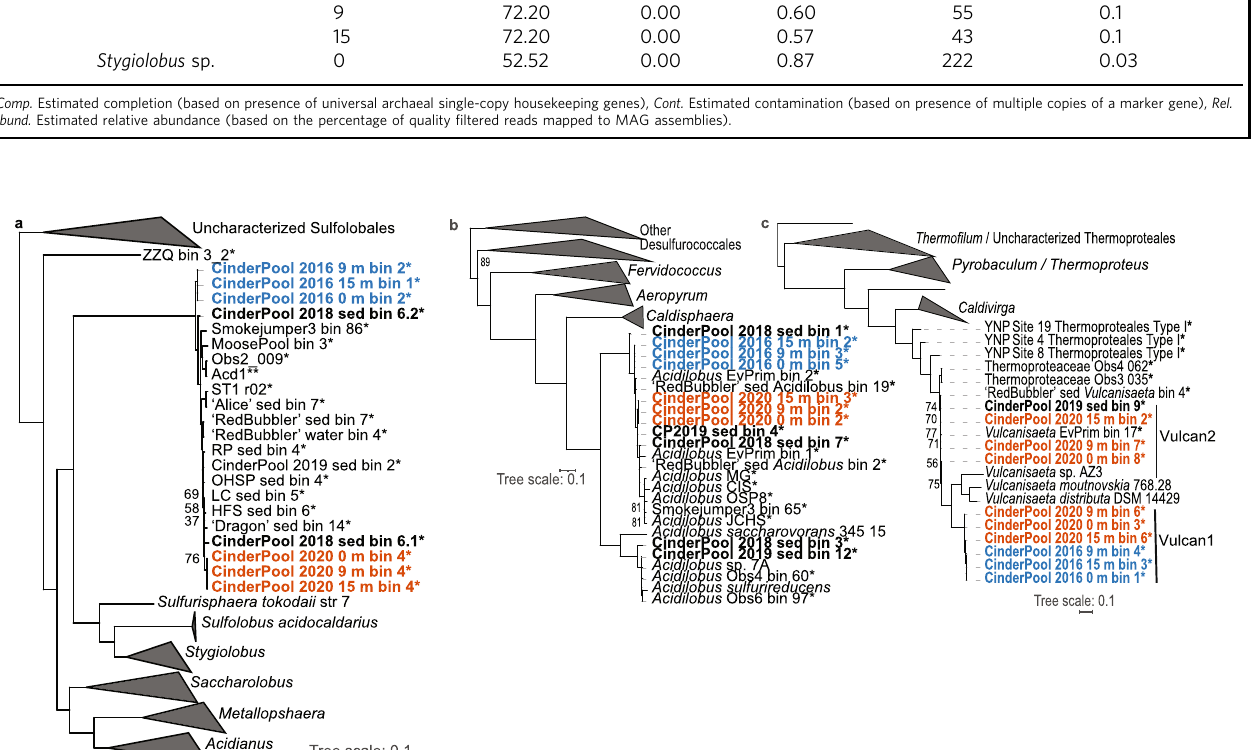
COMMUNICATIONS EARTH & ENVIRONMENT| (2022) 3:205